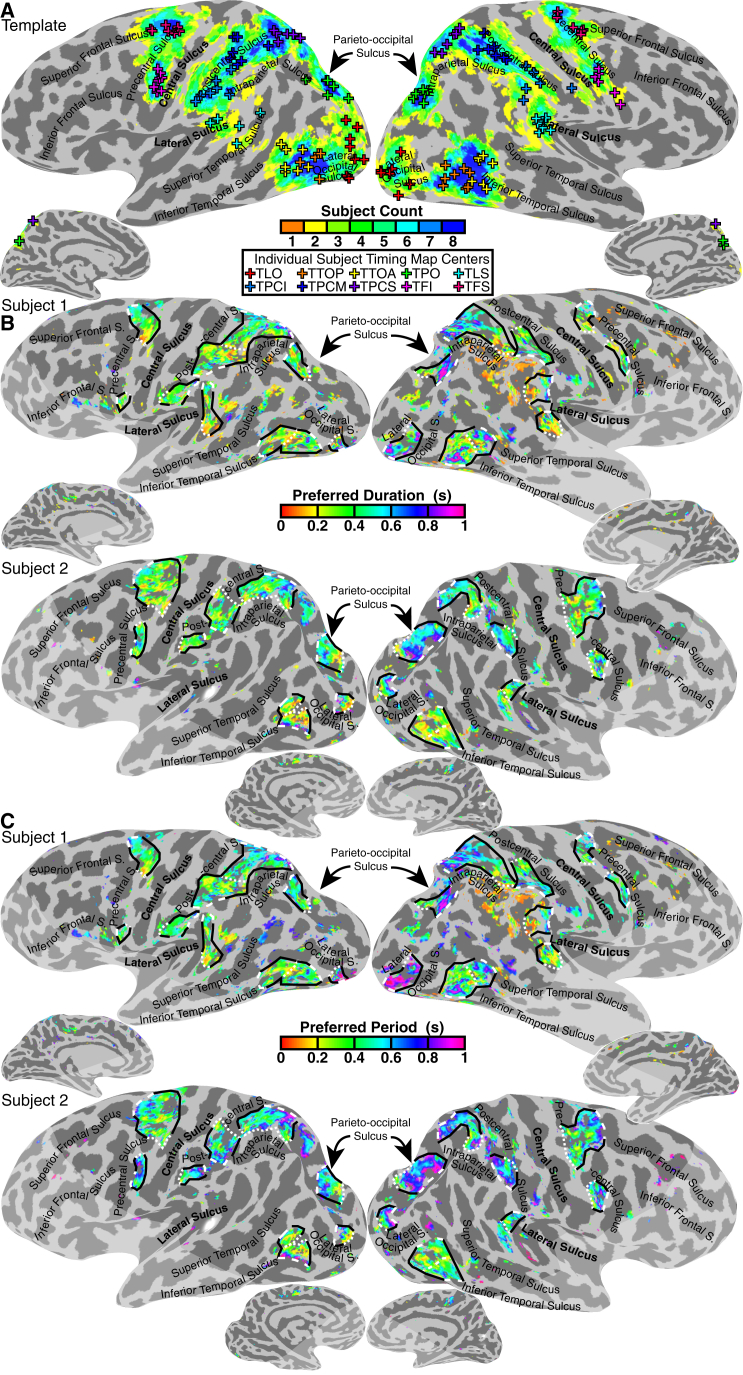
Cortical Locations of Timing Maps and Their Progressions of Preferred Duration and Period(A) Timing map locations transformed onto the N27 (Talairach) template’s cortical surface anatomy (grays; major sulci are labeled in black). Colors show the number of subjects whose maps overlap with each surface location, whereas crosses show the transformed locations of individual subjects’ map centers. See also Table S1 and Figures S2 and S3.(B) Projecting each recording site’s preferred duration (colors; for recording sites with over 10% response variance explained by the response model) onto the subject’s cortical surface anatomy reveals ten maps, each containing a range of timing-selective responses (outlined with black and white lines: fine dashed white lines connect map border sites with the lowest duration preferences, and coarse dashed white lines connect map border sites with the highest duration preferences). See also Figure S2.(C) Preferred period of the same recording sites. See also Figure S3.